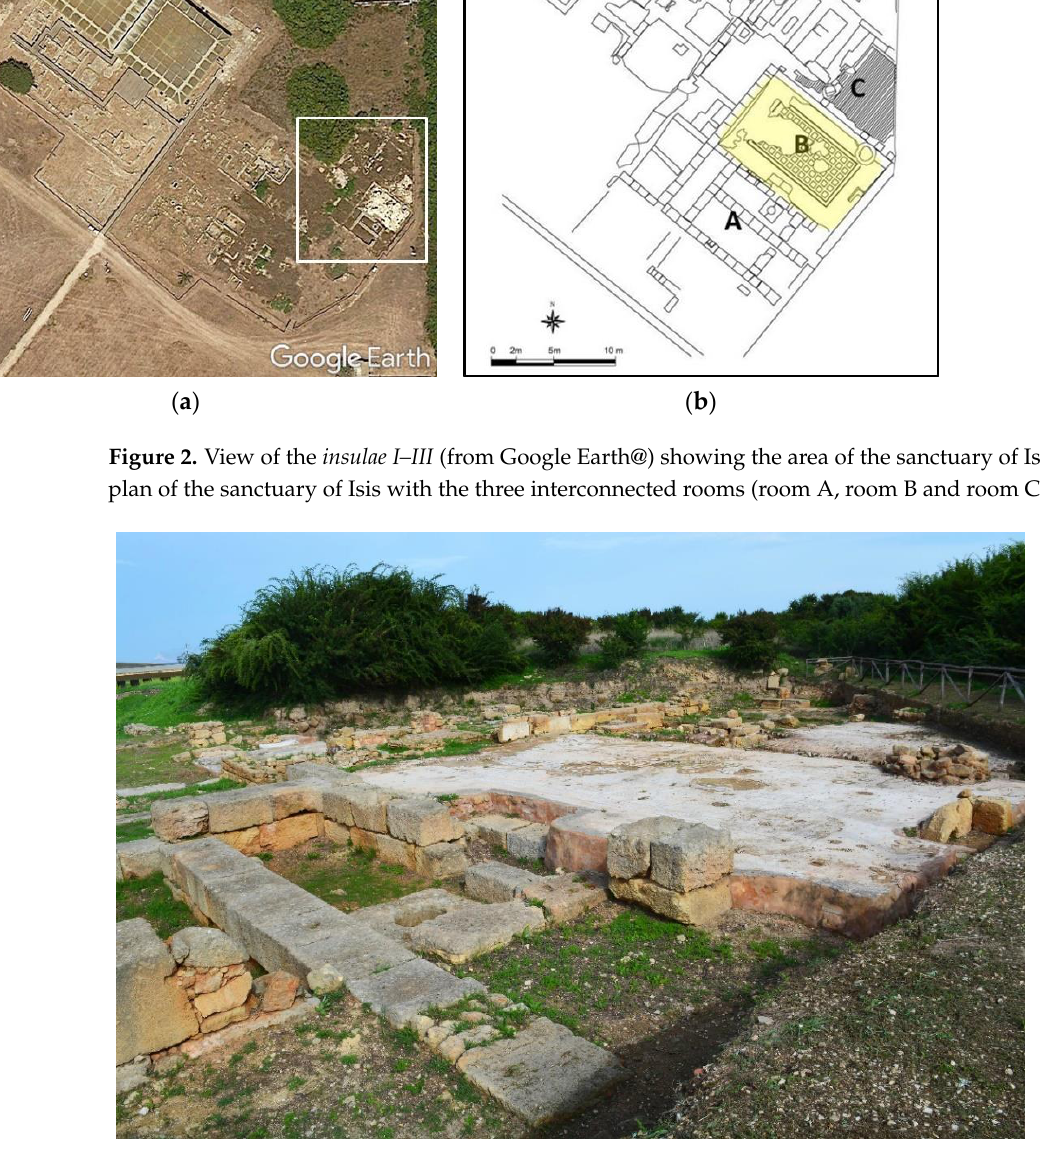
Figure 3. Ruins of the sanctuary of Isis in Lilybaeum from SE.